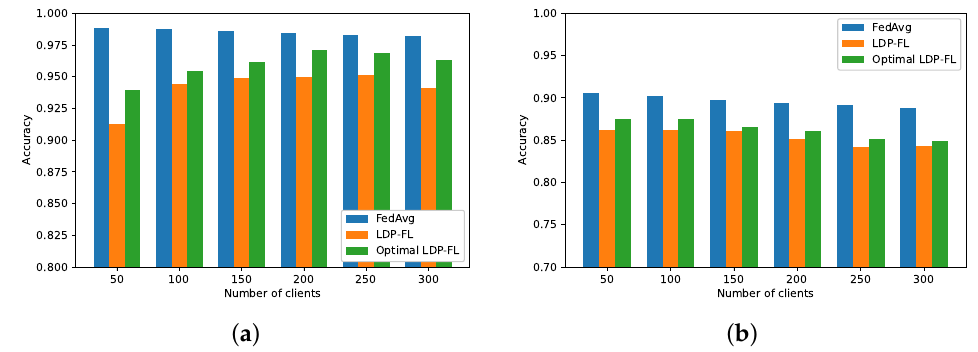
Figure 3. Model accuracy vs. number of clients for different federated learning frameworks on MNIST and Fashion MNIST datasets: ( a ) MNIST and ( b ) Fashion